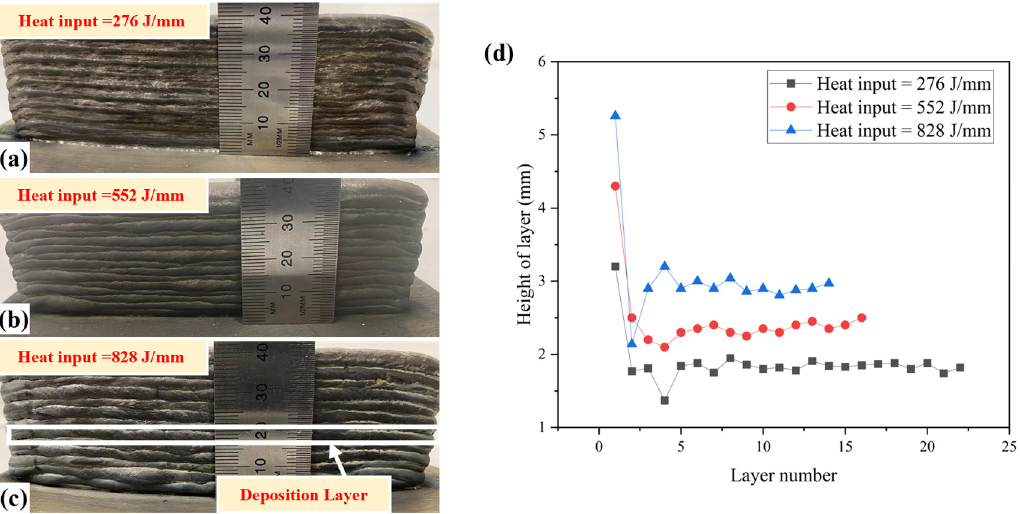
Figure 2. Macro-morphology of the fabricated components with heat input of ( a ) 276 J/mm, ( b ) 552 J/mm and ( c ) 828 J/mm; ( d ) layer height of different heat inputs. ( b ) 552 J/mm and ( c ) 828 J/mm; ( d ) layer height of different heat